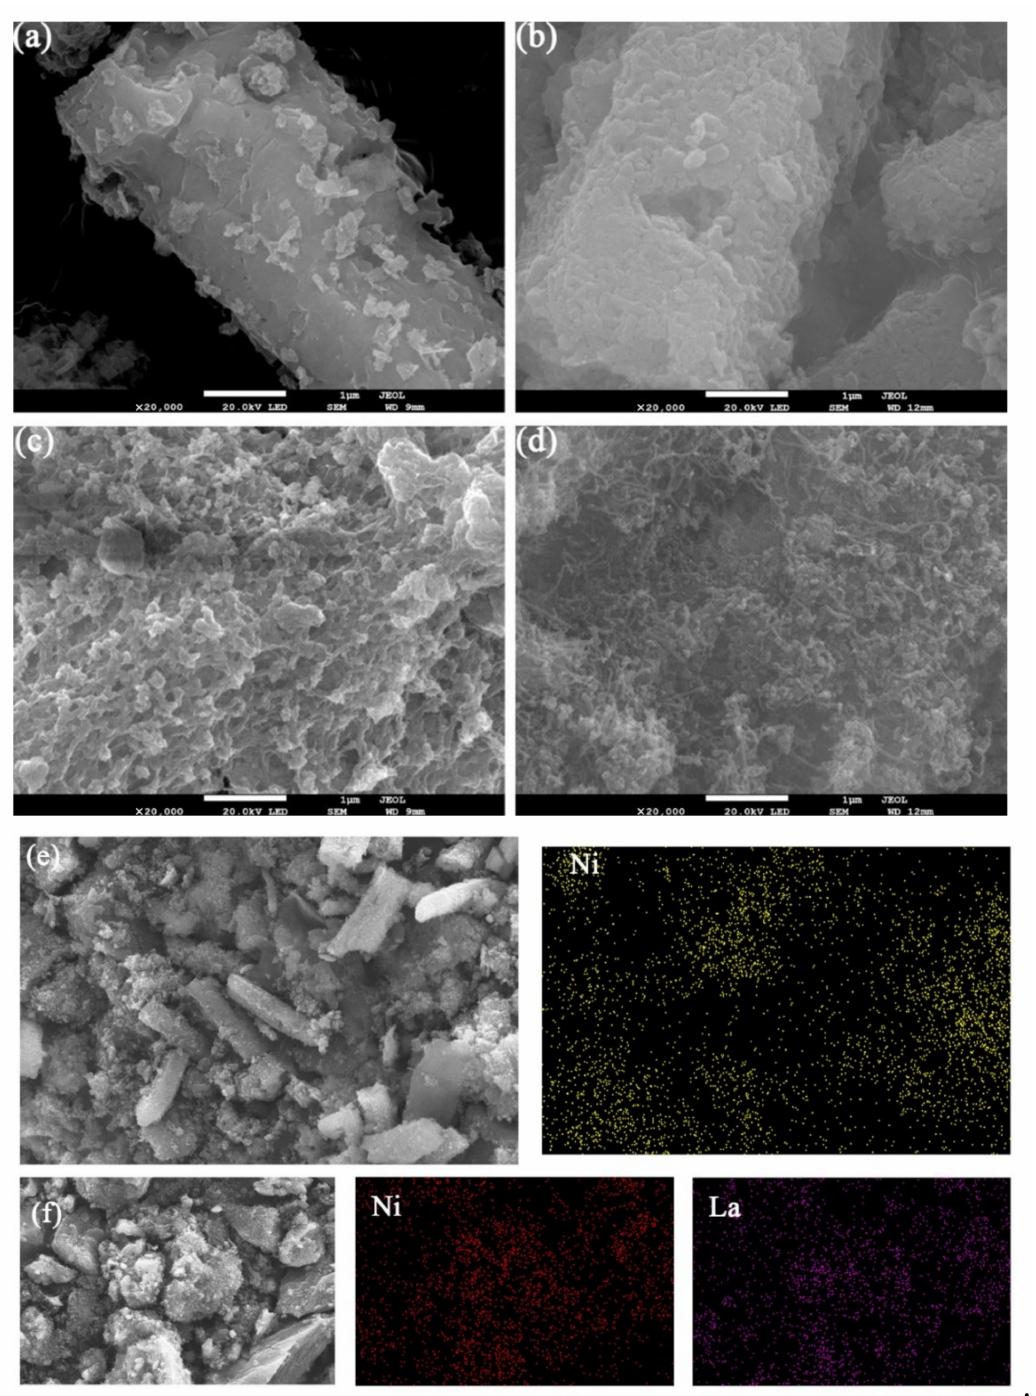
Figure 4. SEM/EDS images of catalysts: ( a ) fresh Ni/ACC(M); ( b ) used Ni/ACC(M); ( c ) fresh Ni- La/ACC(M); ( d ) used Ni-La/ACC(M); ( e ) used Ni/ACC(M) mapping; ( f ) used Ni-La/ACC(M)